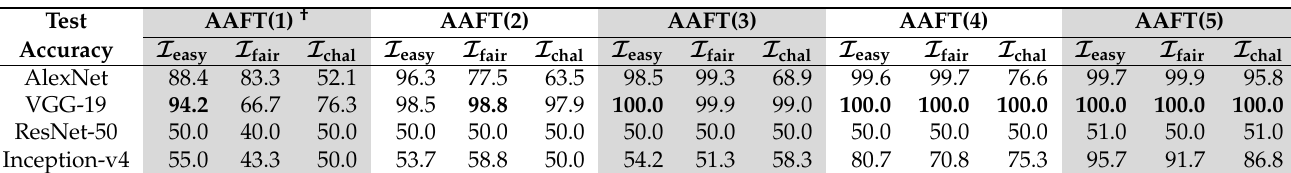
Table 7. The mean of test accuracy for AlexNet, VGG-19, ResNet-50, and Inception-v4 (%).